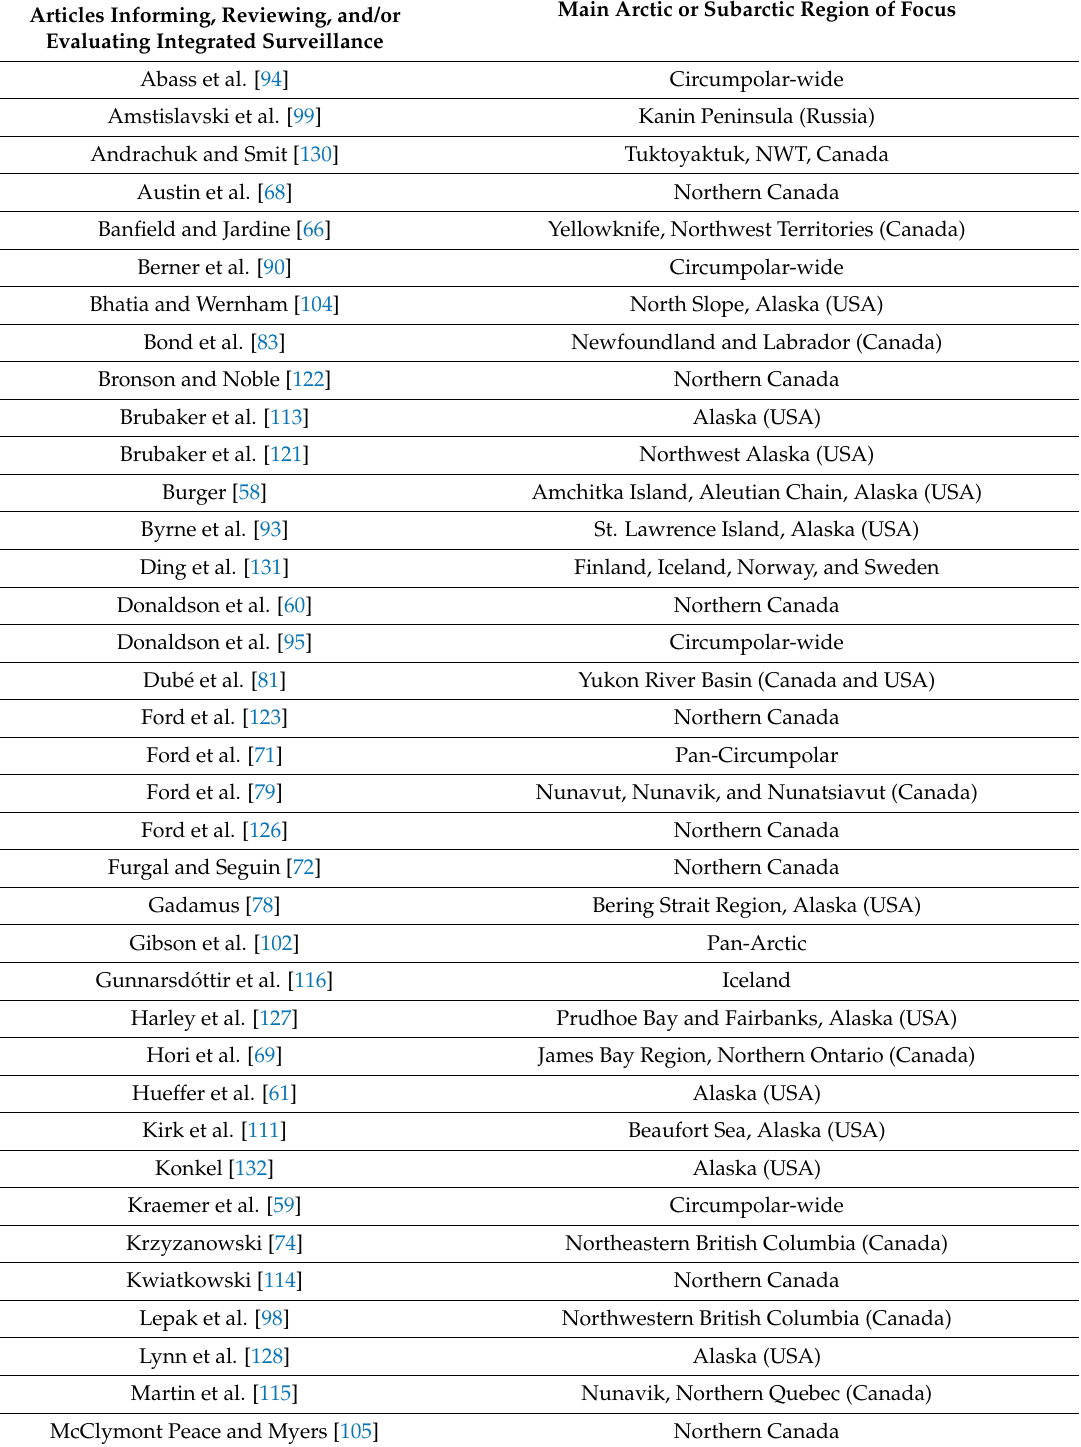
Table A4. Citations and corresponding Arctic or Subarctic region(s) of focus for each of the 85 included articles, comprised of articles that informed, reviewed, and/or recommended integrated surveillance, and articles that focused on the development, implementation, and/or application of integrated surveillance